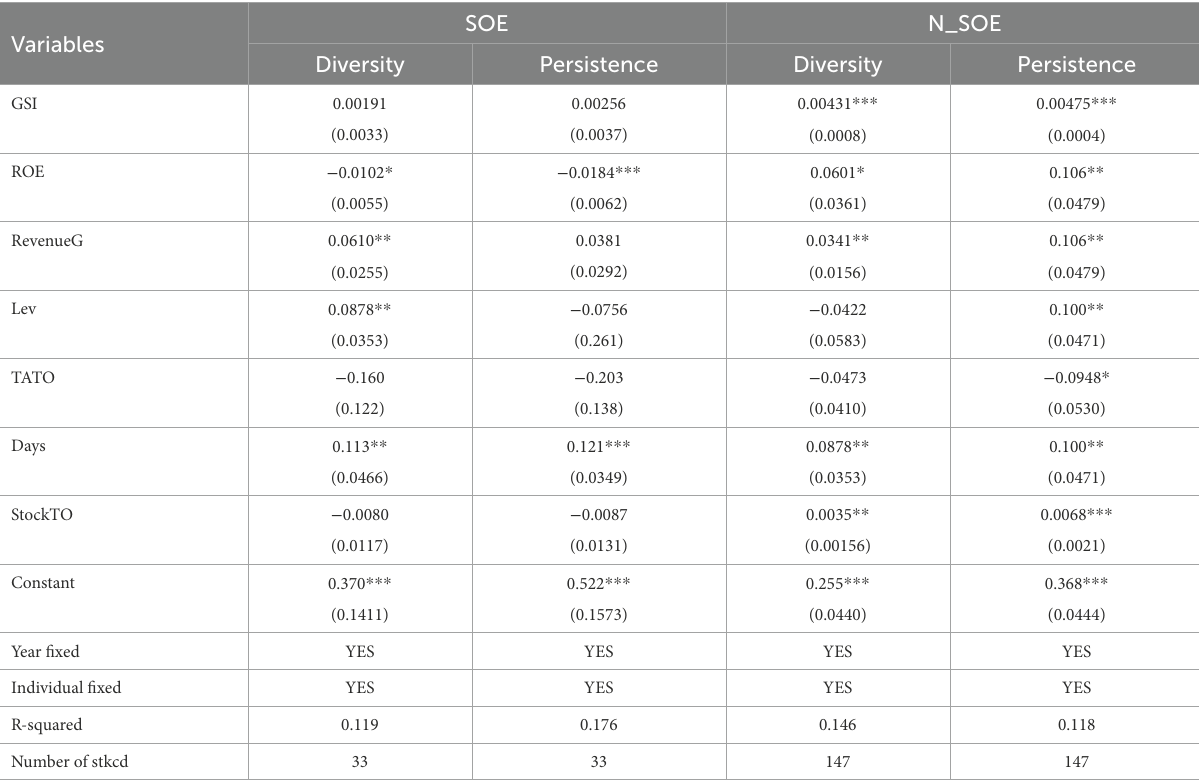
TABLE 3 Empirical results of heterogeneity of property